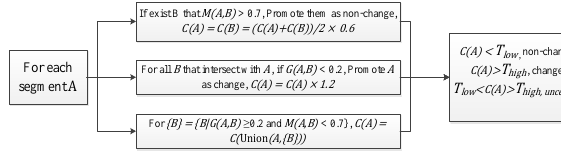
Figure 3. The workflow of the decision tree analysis.